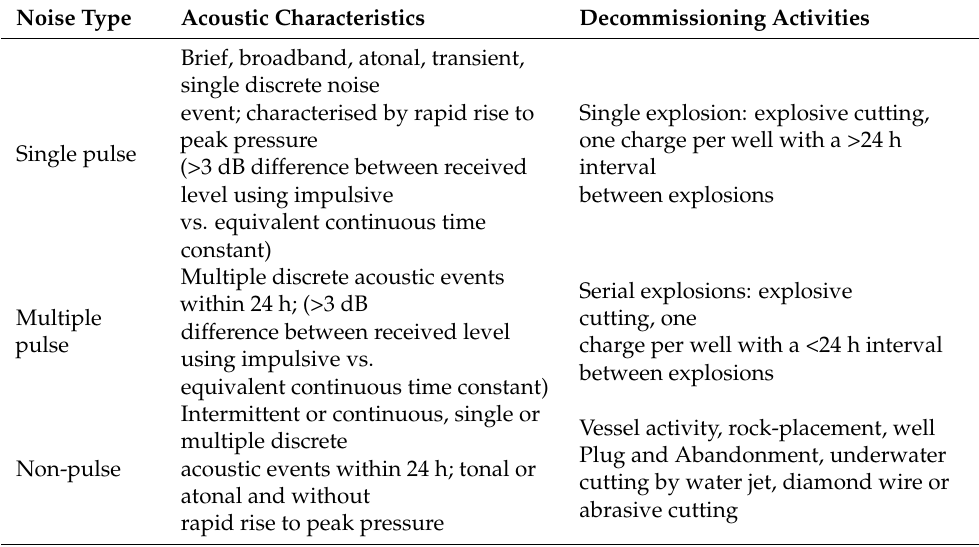
Table 2. Noise types and use of explosives in decommissioning activities. Adapted from